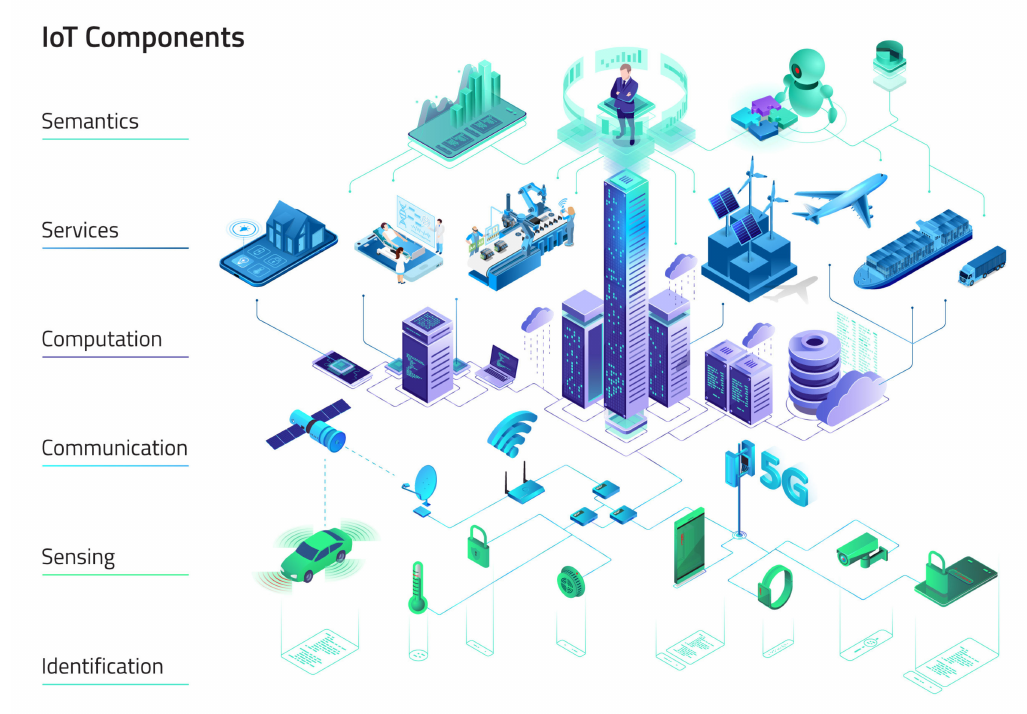
Figure 1. Internet of Things (IoT) Architecture